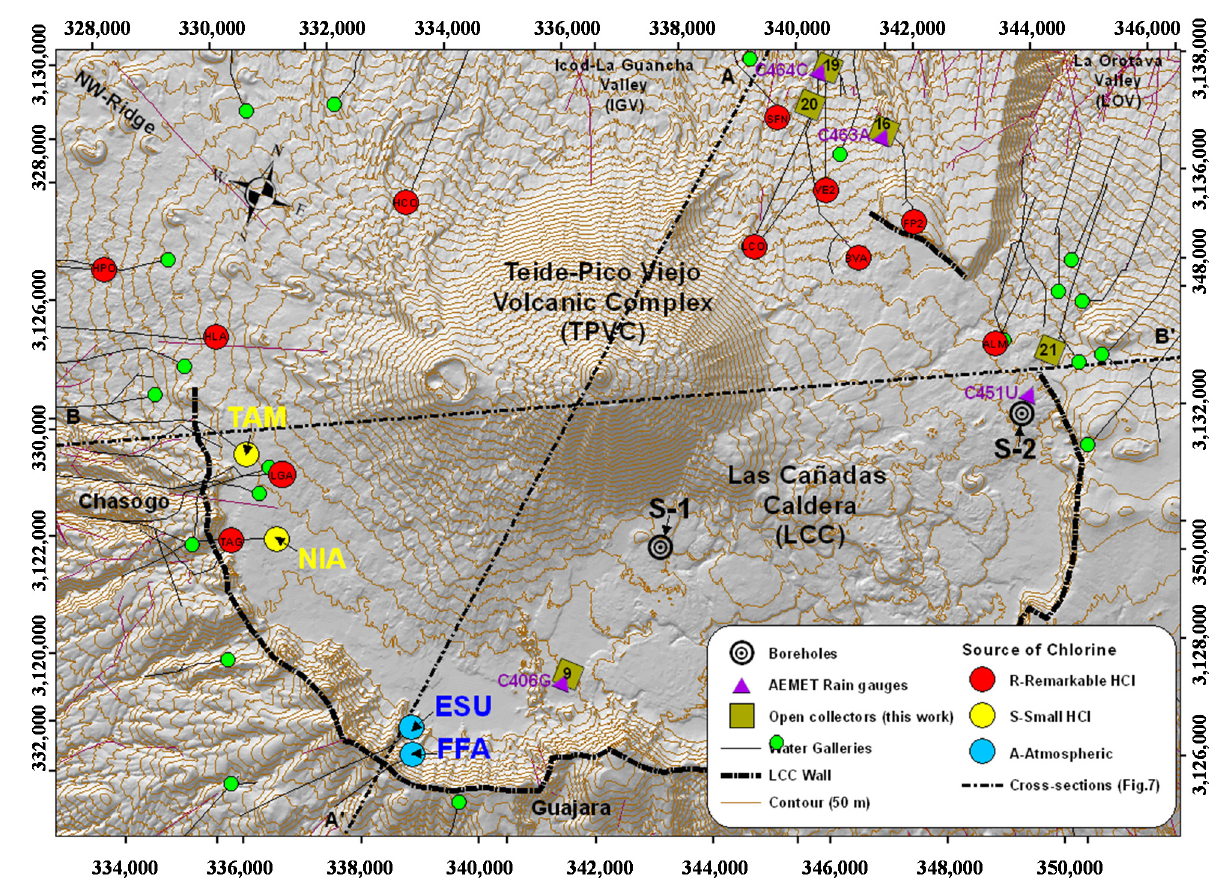
Figure 4. Selected groundwater sampling points in the Las Cañadas Caldera area, clustered by groundwater flow type and origin of chloride by means of C R and Cl/Br values as in Table 2. Open collectors for atmospheric bulk deposition and AEMET weather